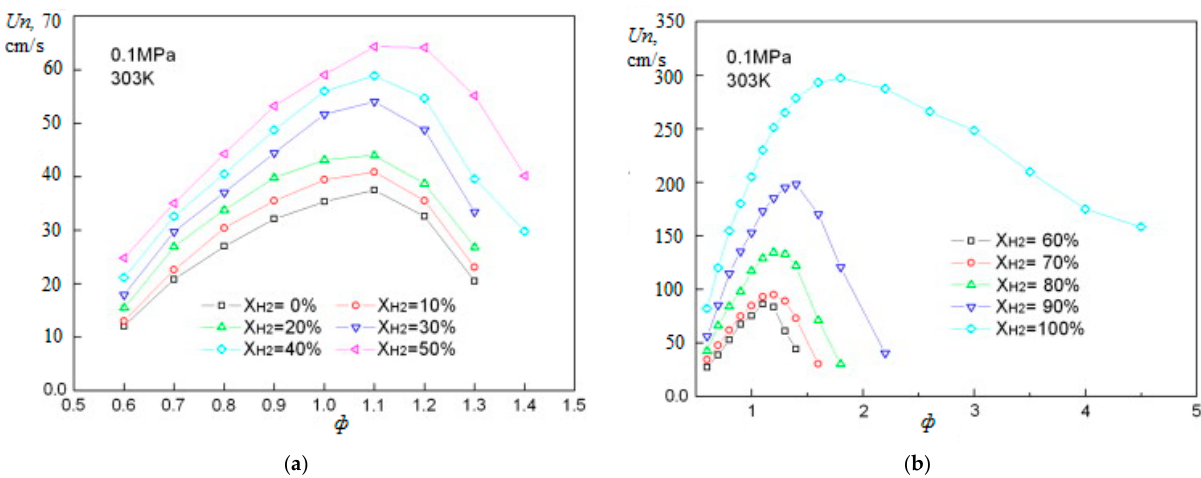
Figure 7. Dependence of the normal flame velocity Un for hydrogen–methane–air mixtures on the equivalence ratio φ under normal conditions for various hydrogen concentration [18]: ( a ) hydrogen concentrations 0–50% vol., ( b ) hydrogen concentrations 60–100% vol. (Adapted with permission from ref. [18], 2009, Elsevier.)